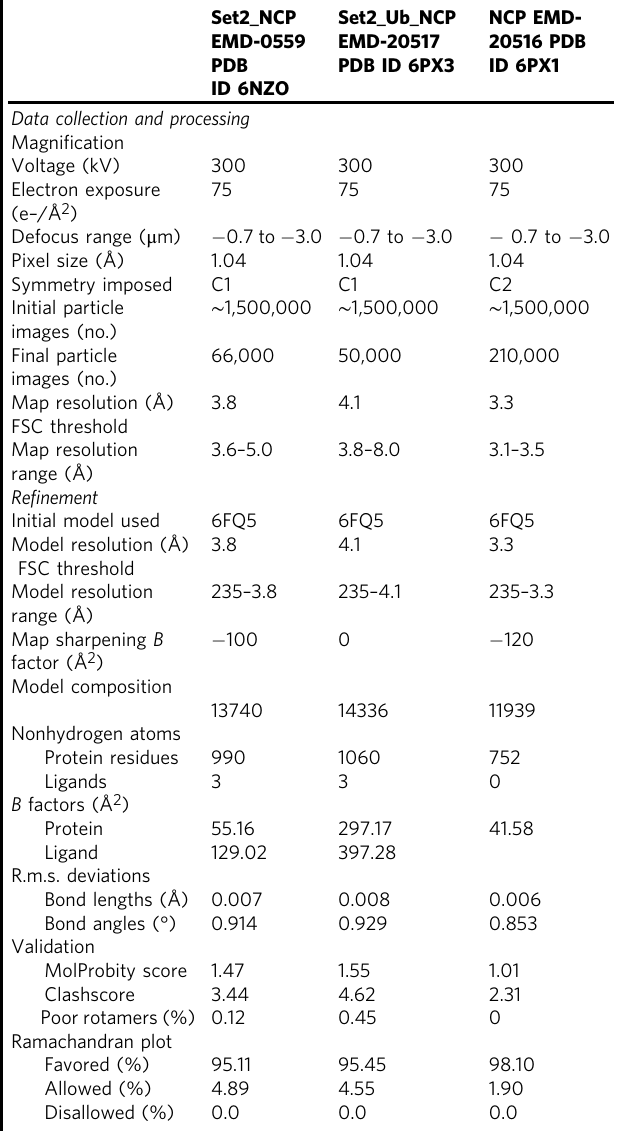
Table 1 Cryo-EM data collection, re fi nement, and